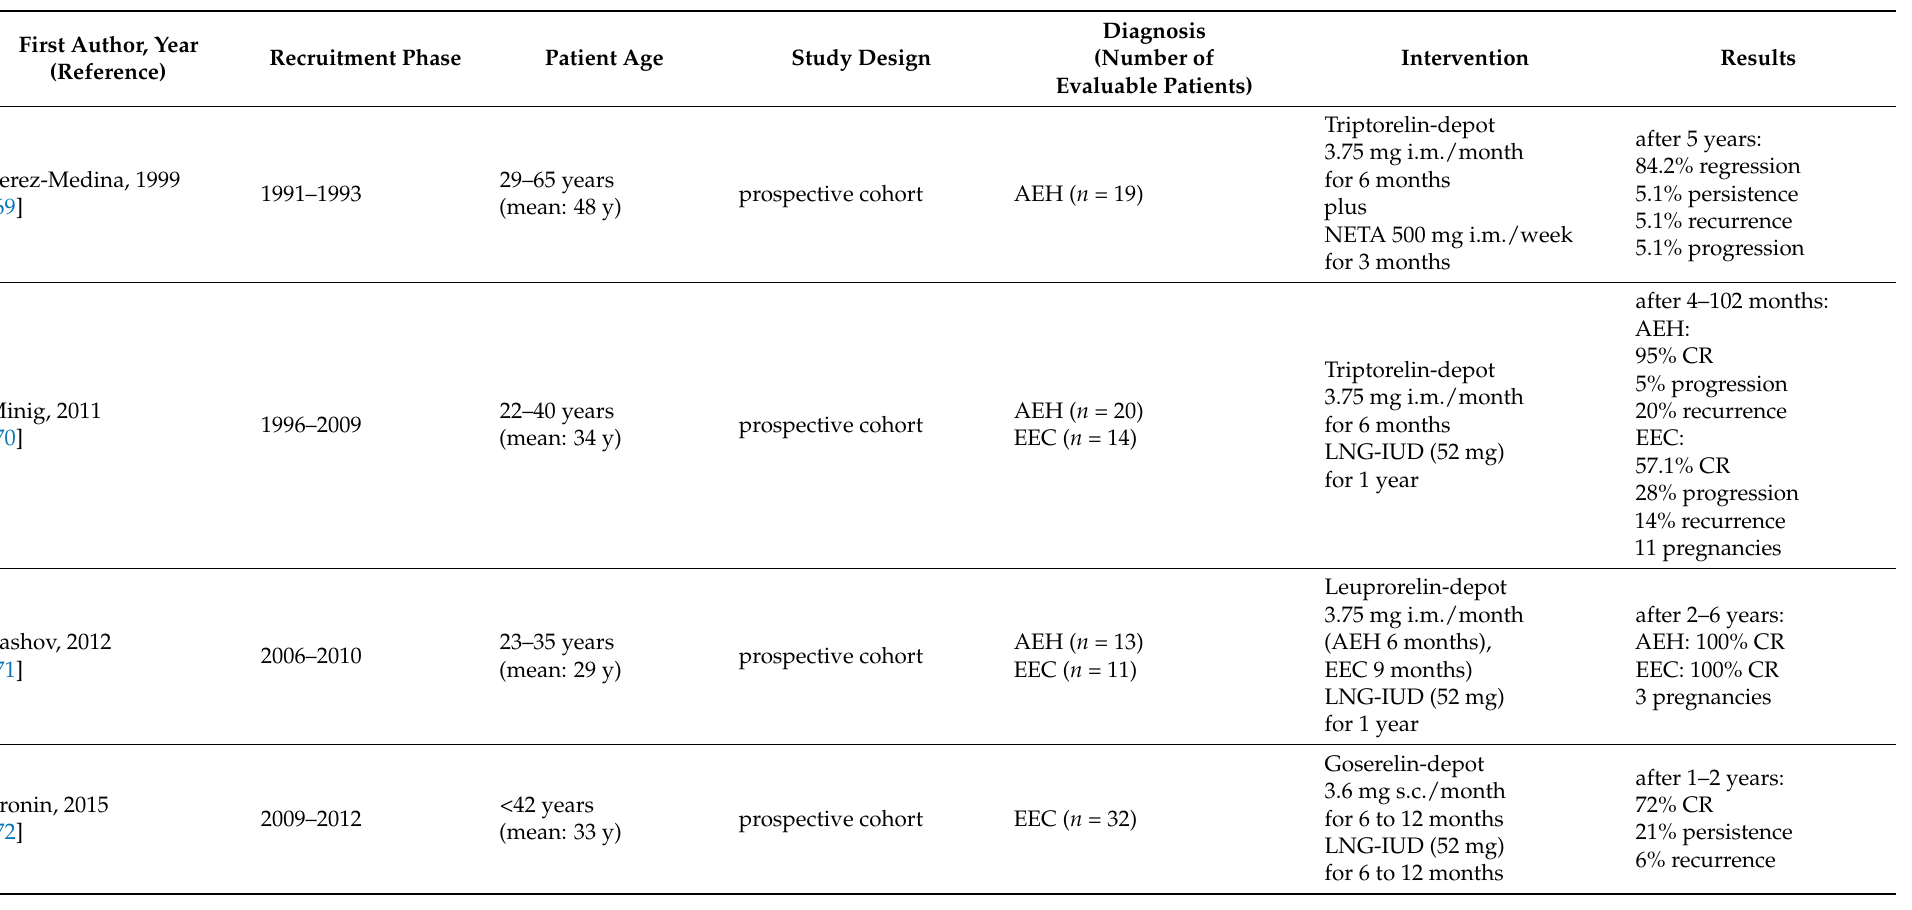
Table 1. Suppression of ovarian estrogen production through GnRH-analogs as treatment for atypical endometrial hyperplasia (AEH) and early endometrial cancer